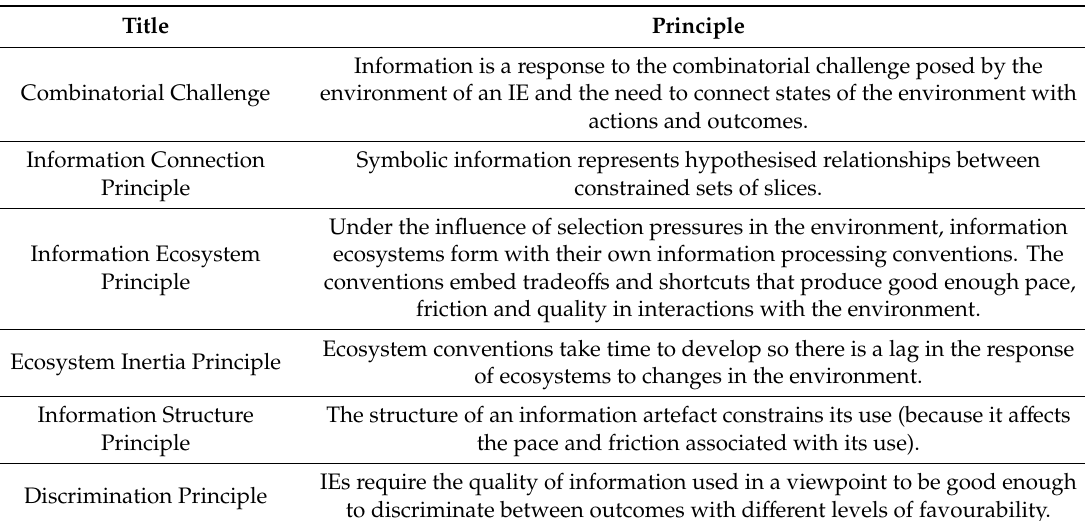
Table 1. Information evolution